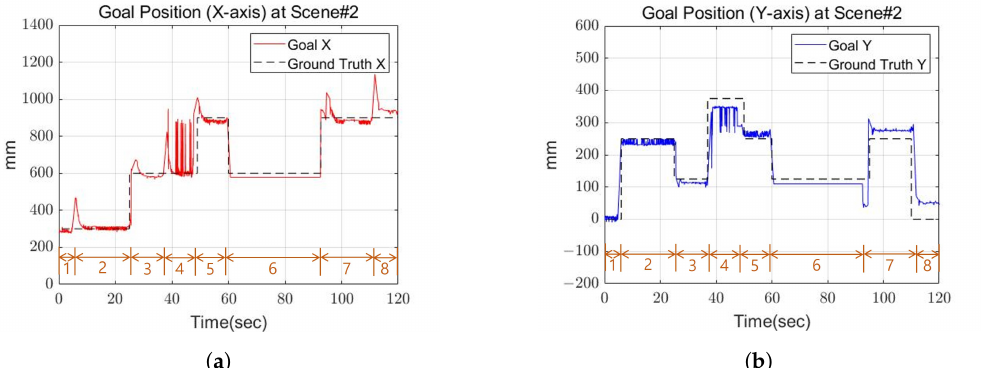
Figure 18. The goal position of Scene 2. ( a ) X-axis goal position at Scene 2; ( b ) Y-axis goal position at Scene 2.